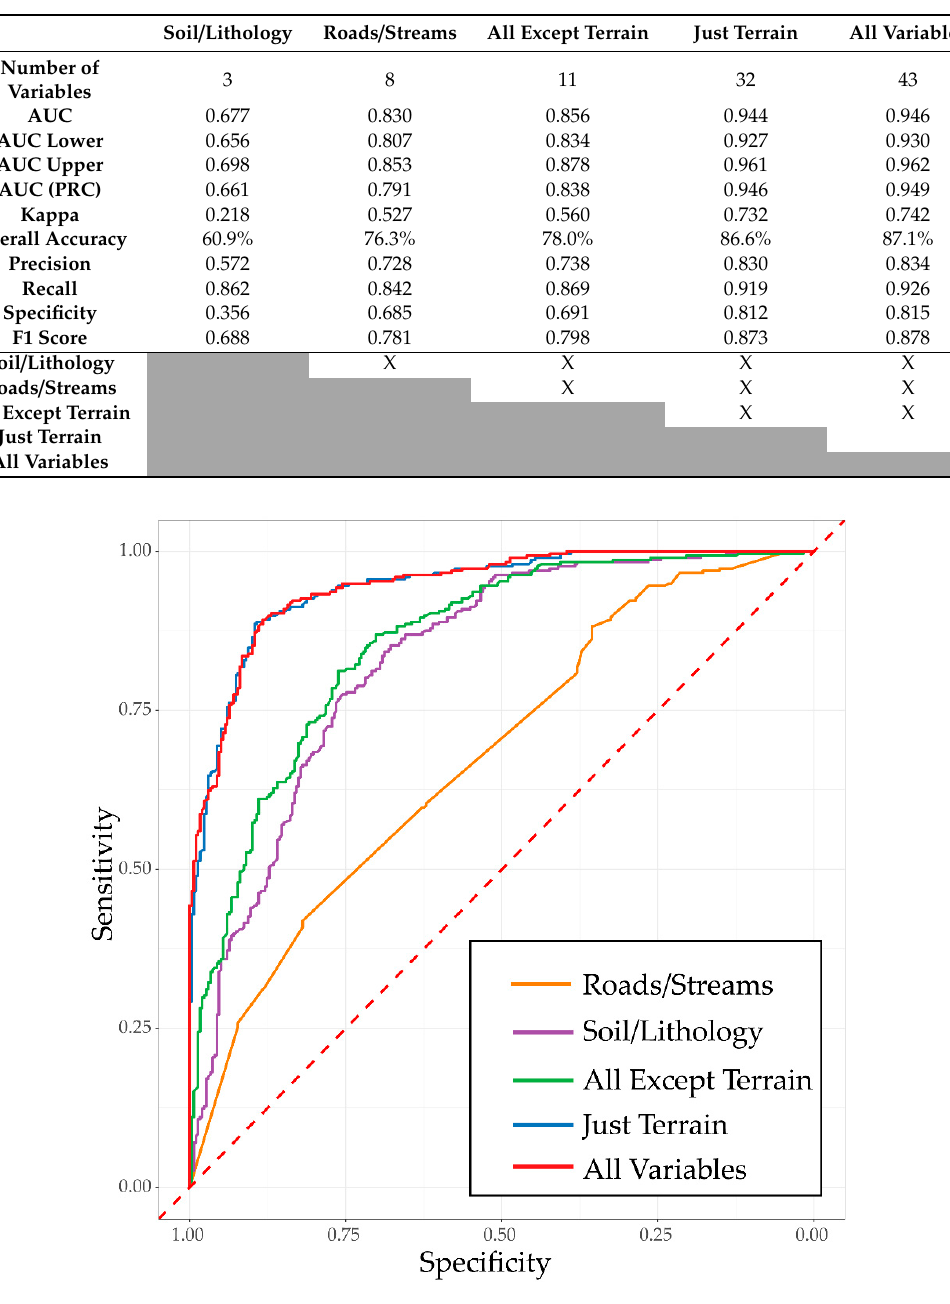
Figure 6. ROC curve comparison for different feature spaces.